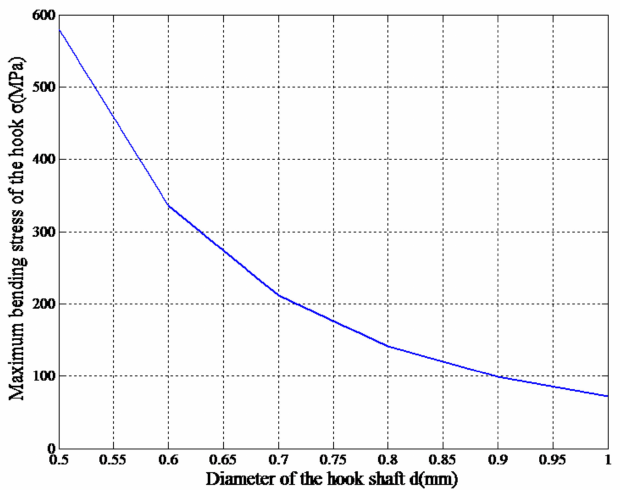
Figure 6. Relationship of maximum bending stress of hook with hook shaft diameter.